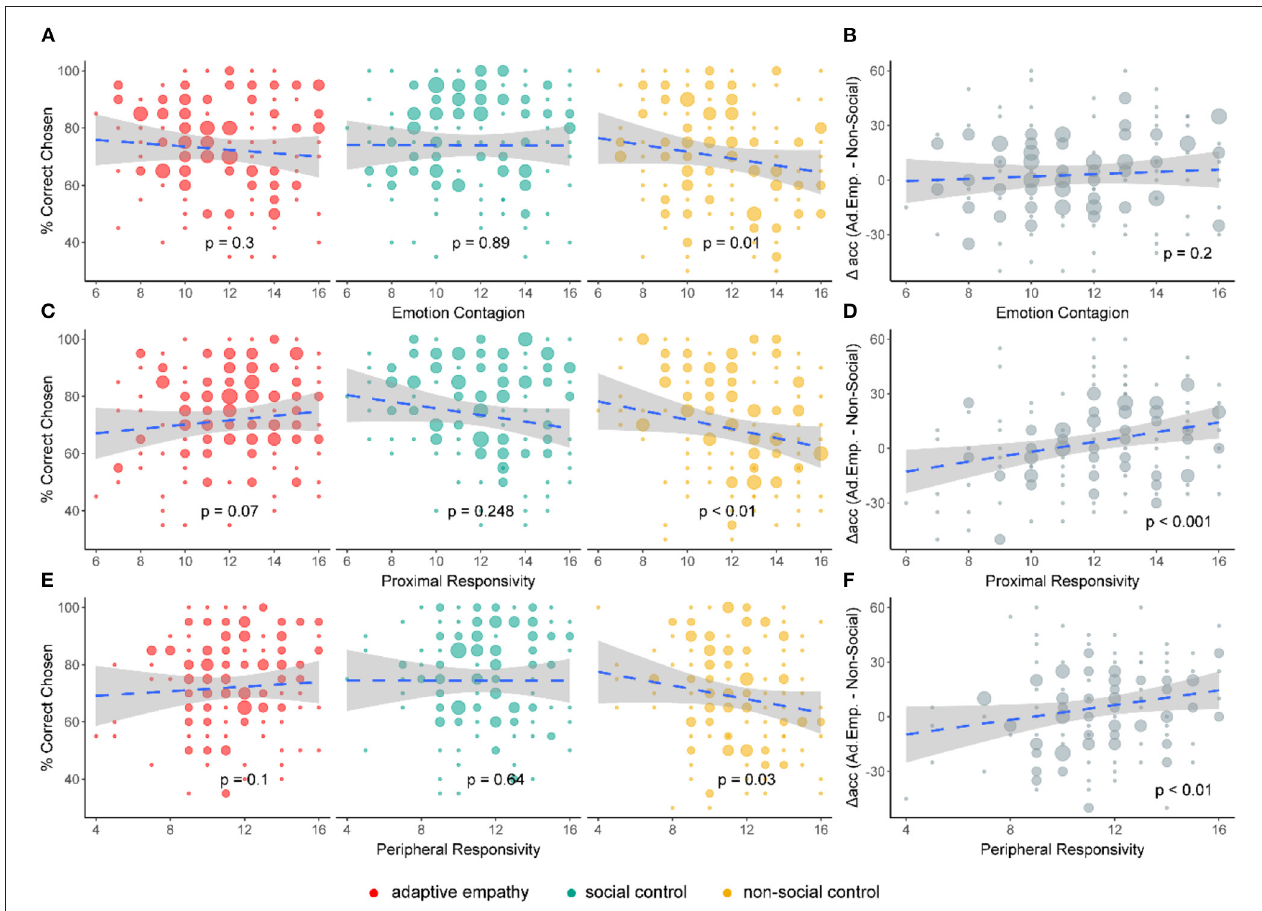
FIGURE 4 | Emotional empathy subscales. (A) Correlations between task conditions and emotional empathy trait: participants high in emotional contagion exhibited a deficit in learning in the non-social control condition. No such deficit was found for other conditions. (B) Correlation of difference in accuracy between adaptive empathy and non-social control with emotional empathy trait: there was no gap between conditions across emotion contagion scores. (C) Same as (A) , but for the proximal responsivity subscale, showing a learning deficit in non-social control conditions for higher scores. (D) Same as (B) , but for the proximal responsivity subscale: participants high in proximal responsivity had a larger gap in accuracy between the two conditions. (E) Same as (A) , but for the peripheral responsivity subscale, showing a learning deficit in non-social control conditions for higher scores. (F) Same as (B) , but for the peripheral responsivity subscale: participants high in peripheral responsivity exhibited a larger gap in accuracy between the two